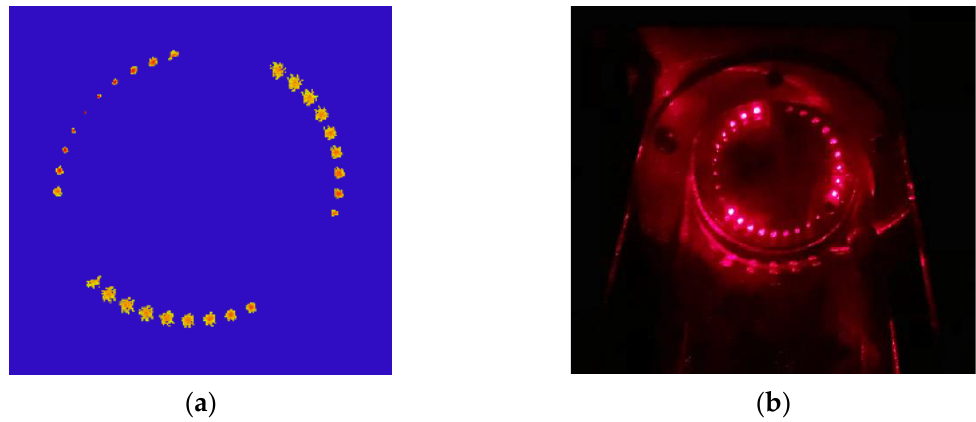
Figure 3. Light spot distribution on the concave mirror ( a ) Optical simulation result.; ( b ) Picture of the gas chamber.